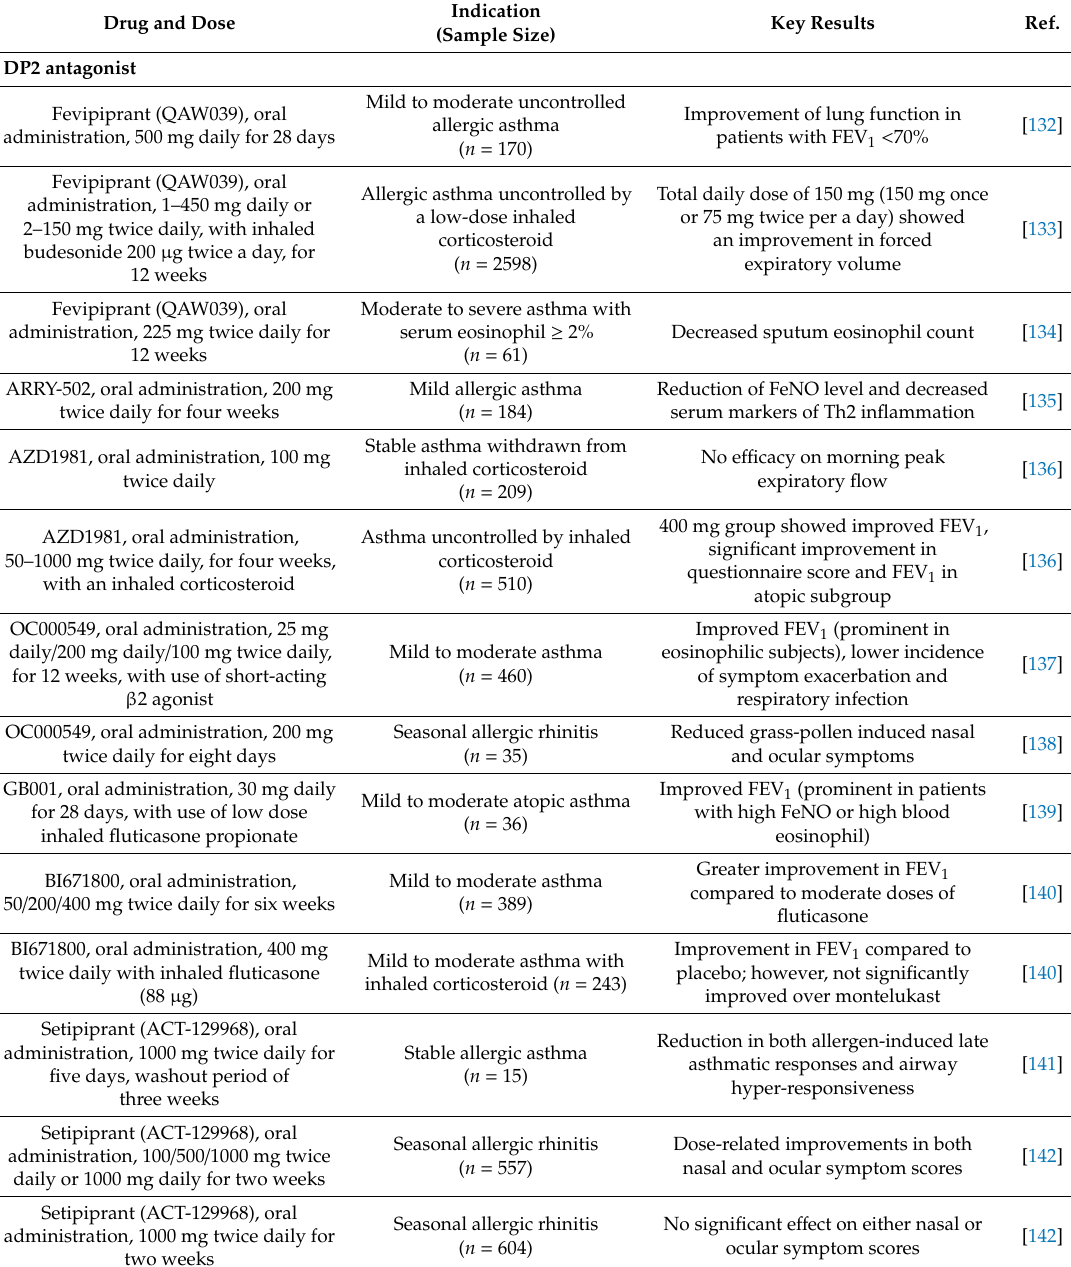
Table 2. Summary of clinical studies on pharmacologic agents targeting PGs in asthma and allergic rhinitis. Drug and Dose